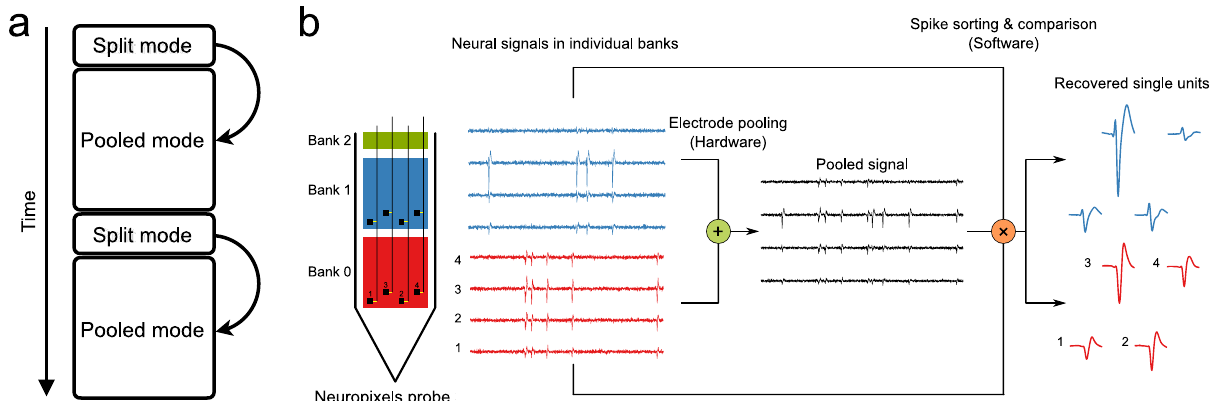
Fig. 3 Work fl ow proposed for electrode pooling. a Time line of an experiment, alternating short split, and long pooled recording sessions. b Electrode pooling using the Neuropixels probe. Recording sites (black squares, numbered from 1 to 4) in the same relative location of each bank can be pooled to a single wire by closing the switches (yellow). This generates the pooled signal (black), which is a weighted average of the signals detected in each bank (red and blue traces). From the pooled signal one recovers distinct spike shapes by spike-sorting. A comparison to the spike shapes observed in split-mode recordings allows the correct allocation of each spike to the electrodes